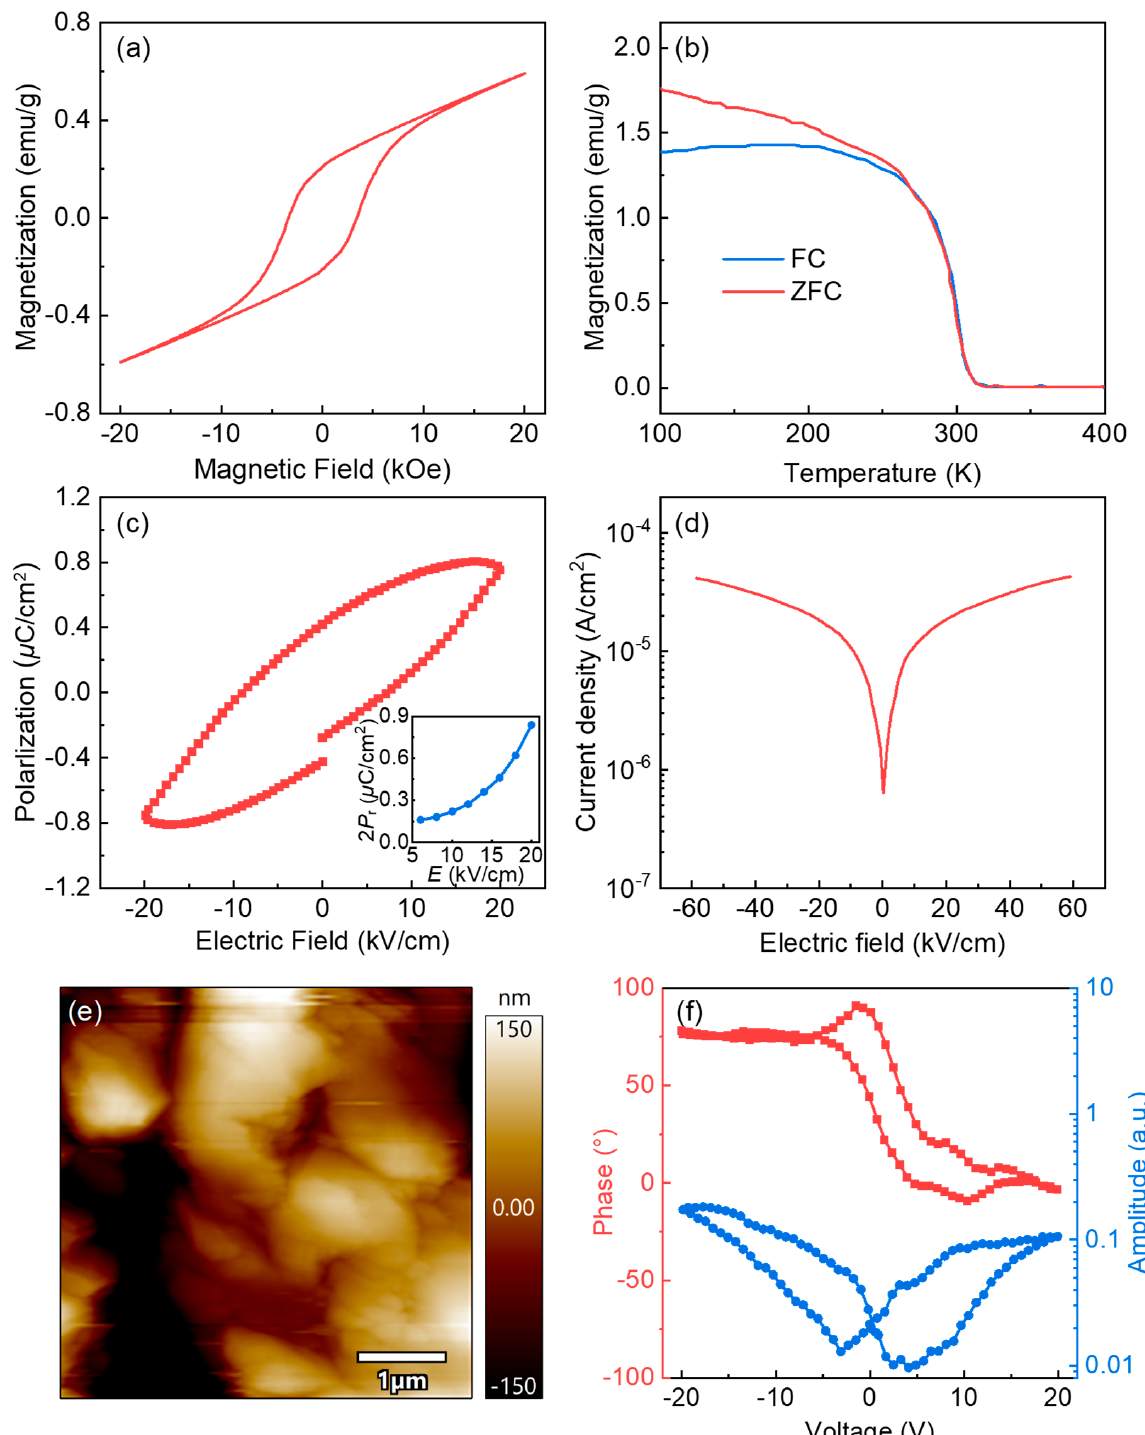
Figure 4. ( a ) Field-dependent and ( b ) temperature-dependent magnetization of Pr2FeAlO6 com- pound. ( c ) Ferroelectric hysteresis loops at room temperature for Pr2FeAlO6. Inset shows the values of remnant polarization 2Pr as a function of electric field.( d ) The leakage current density. ( e ) Topog- raphy with corresponding PFM image. ( f ) The local butterfly-type piezoresponse hysteresis loop and polarization switching.